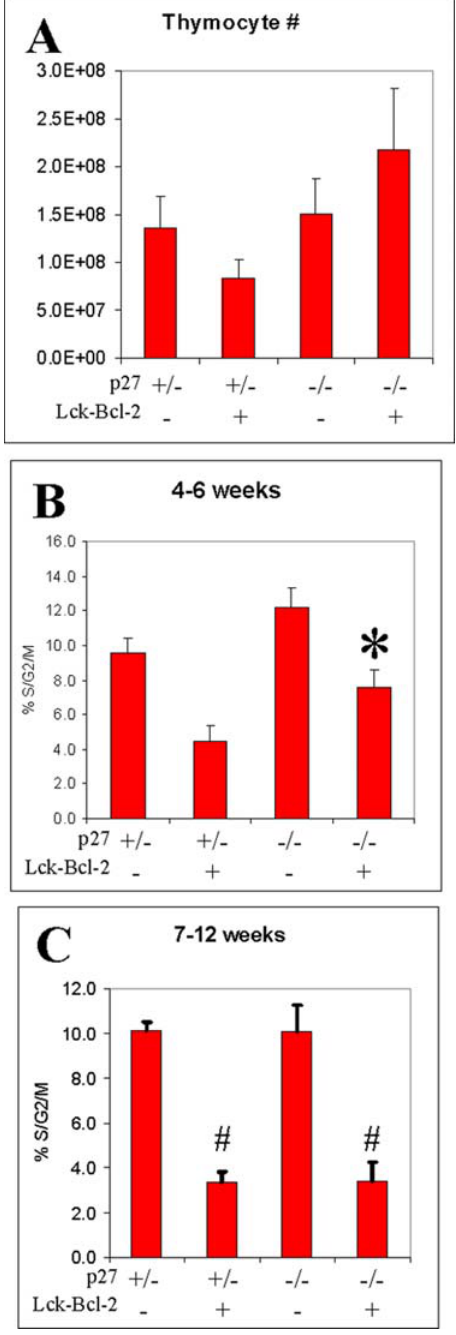
Figure 3. Thymocyte cellularity and cell cycle in p27 2 / 2 Lck- Bcl-2 mice. A) Total thymocyte cellularity from mice of the indicated genotypes (Mean + / 2 SEM) between 4 and 12 weeks of age is shown. B) DNA content analysis was performed on freshly isolated thymocytes on mice of the indicated genotypes between 4 and 6 weeks of age. The mean and SD of at least 3 mice per group is shown. * P , 0.01 versus the control p27 + / 2 , p27 + / 2 Lck-Bcl-2 and p27 2 / 2 mice using the unpaired Students T test. C) DNA content analysis was performed on freshly isolated thymocytes on mice of the indicated genotypes between 7 and 12 weeks of age. The mean and SD of at least 3 mice per group is shown. # P , 0.01 versus both the p27 + / 2 and p27 2 / 2 mice using the unpaired Students T test. The p27 + / 2 Lck-Bcl-2 mice were not significantly different than the P27 2 / 2 Lck-Bcl-2 mice in this age group (P=0.94).